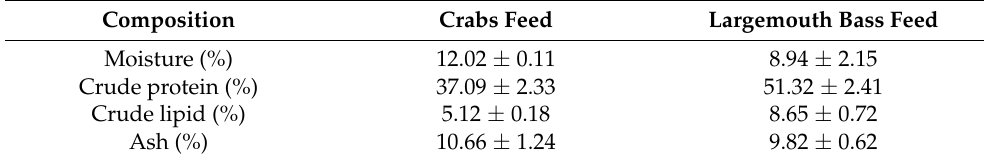
Table 1. Formulation and proximate composition of the experimental diet (% dry weight).